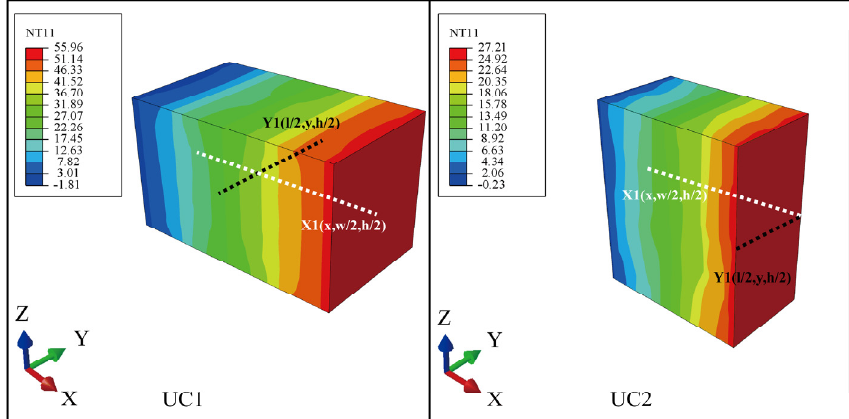
Figure 12. Temperature distributions for the calculation of λ xx in UC1 and UC2.